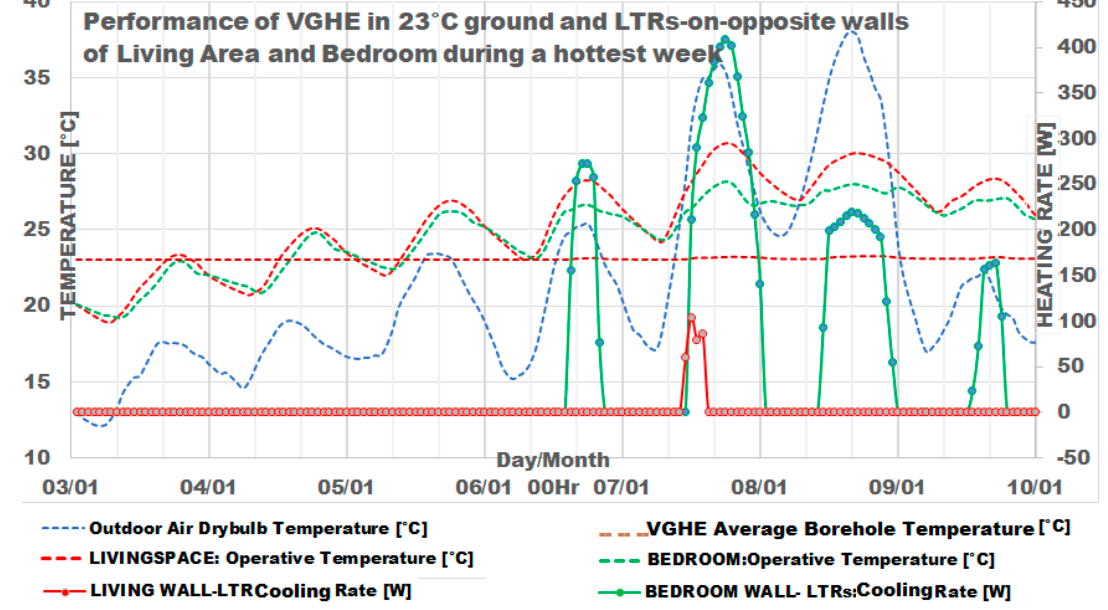
Figure 7. LTRs’ Cooling Rates and Indoor Temperatures with VGHE in 23 °C ground - hottest week. Figure 7. Indoor Temperatures with 23 ◦ C far ground temperature, hottest week.